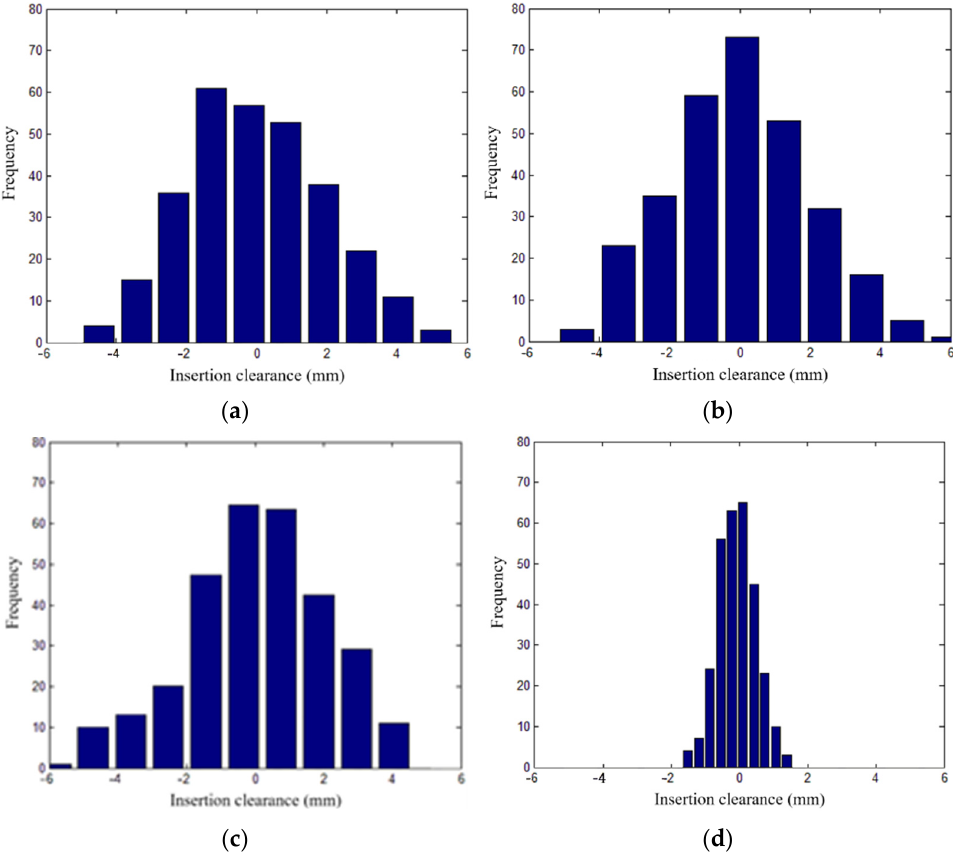
Figure 24. Influence of the manufacturing error and positioning error of each component on the insertion clearance of the F block. ( a ) No manufacturing error of the segment; ( b ) No positioning error in the rT direction; ( c ) No positioning error in the rR direction; ( d ) No positioning error in the rZ direction. Table 9. Influencing factors of the insertion clearance of the F block.